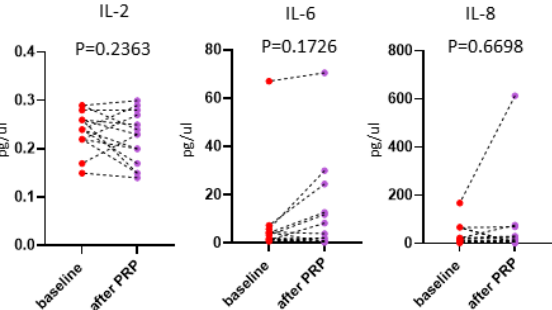
Figure 5. Urinary cytokine expression in the patients with rUTI and control subjects. ( A ) Urinary inflammatory cytokines and growth factors in the controls ( n = 25) and patients with rUTI at baseline ( n = 29). The level of urinary inflammatory cytokines IL-6 and IL-8, and BDNF levels were significantly higher in patients with rUTI at baseline (nonparametric independent t -test), while the levels of IL-2, NGF, and VEGF were significantly lower. ( B ) Comparison of urinary inflammatory cytokines and growth factors between the patients with rUTI at baseline and after PRP injections ( n = 14). The level of urinary BDNF in the patients with rUTI decreased after PRP injection (nonparametric paired t -test).